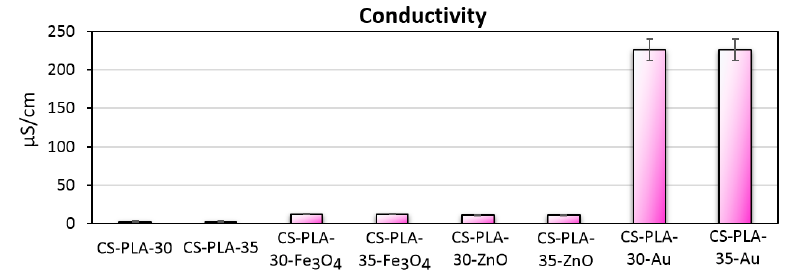
Figure 4. Conductivity of the prepared scaffolds.